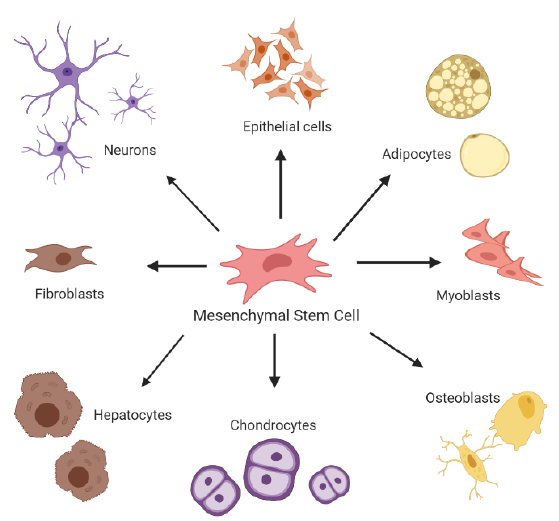
Figure2. Overviewofin-vitrodi ff erentiationofMSCs(mesenchymalstromalcells). Note: Figurecreated Figure 2. Overview of in-vitro differentiation of MSCs (mesenchymal stromal cells). Note: Figure with BioRender.com. created with BioRender.com.